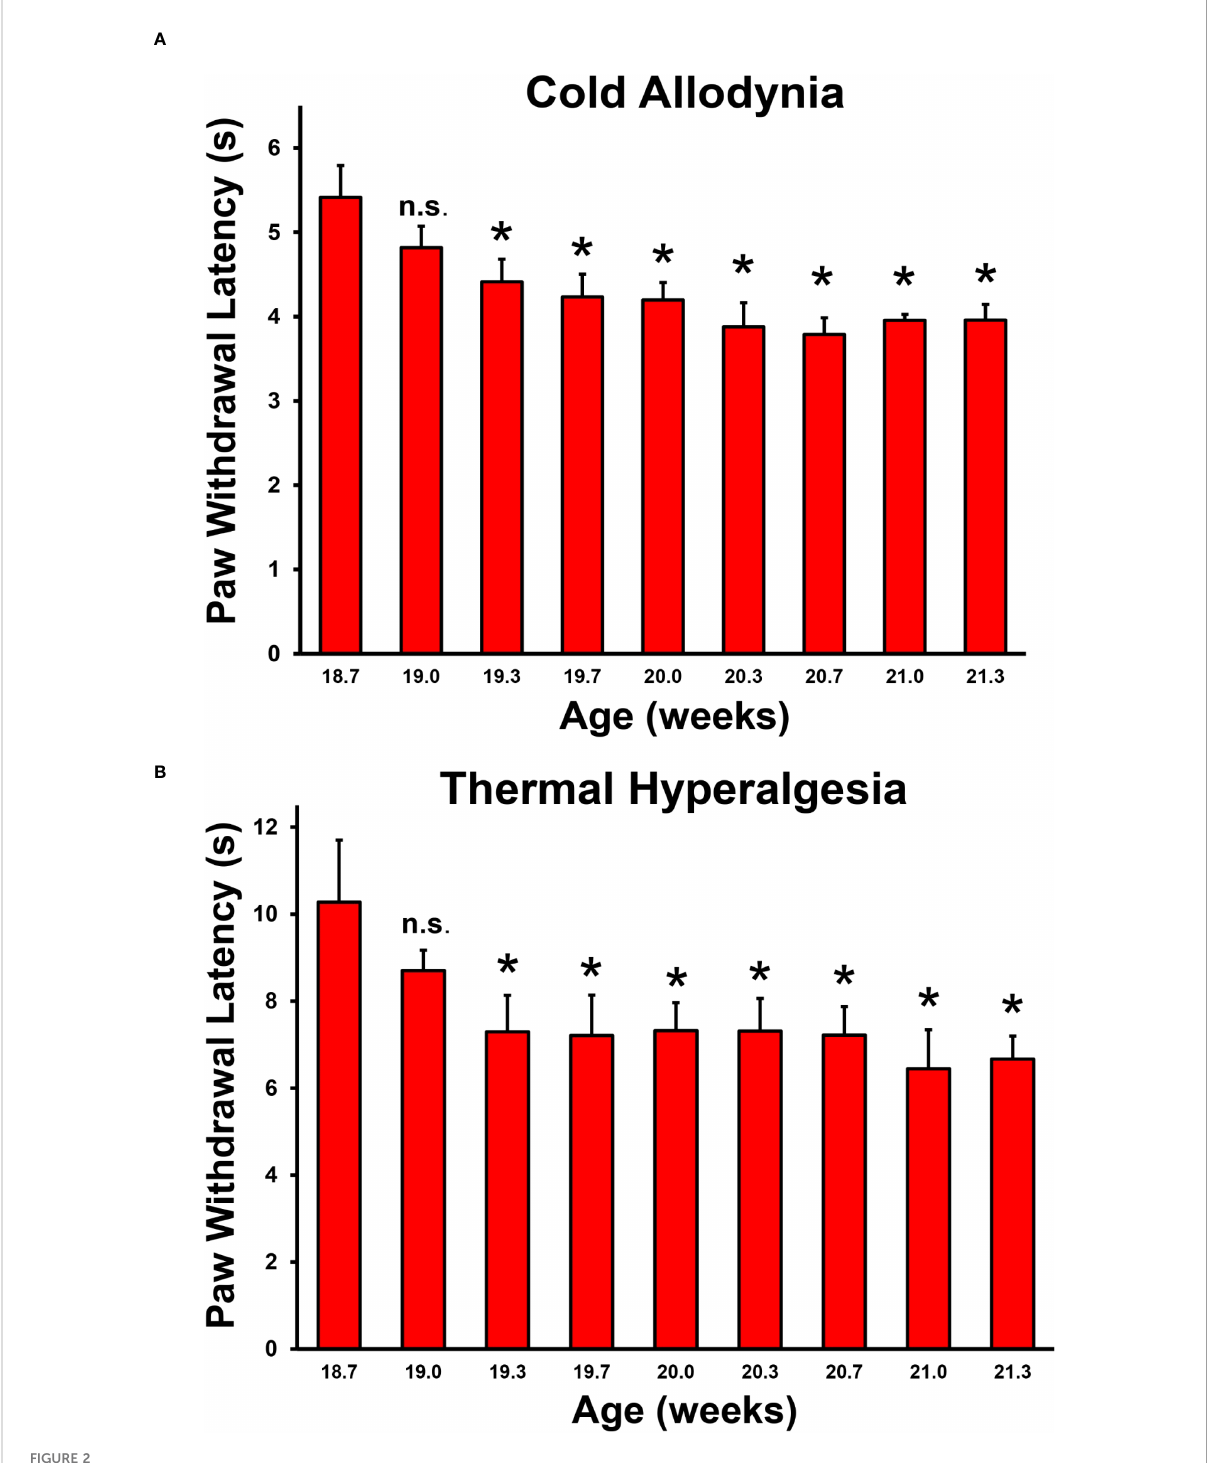
FIGURE 2 Baseline and disease re fl exive neurobehavioral nociception in adult female CD86-de fi cient NOD mice. Bar histograms from a representative experiment demonstrate mean paw withdrawal latencies (in seconds) testing for cold allodynia (A) and thermal hyperalgesia (B) prior to and around the expected onset of chronic demyelinating neuritis. Statistically signi fi cant mean reduced paw withdrawal latencies for cold allodynia (A) and thermal hyperalgesia (B) are observed in this spontaneous chronic demyelinating neuritis model from 19.3 weeks of age, at the approximate known onset of chronic in fl ammation, demyelination and weakness (20 weeks of age). Error bars indicates standard error of the mean *p < 0.05. n.s. not signi fi cant, N =